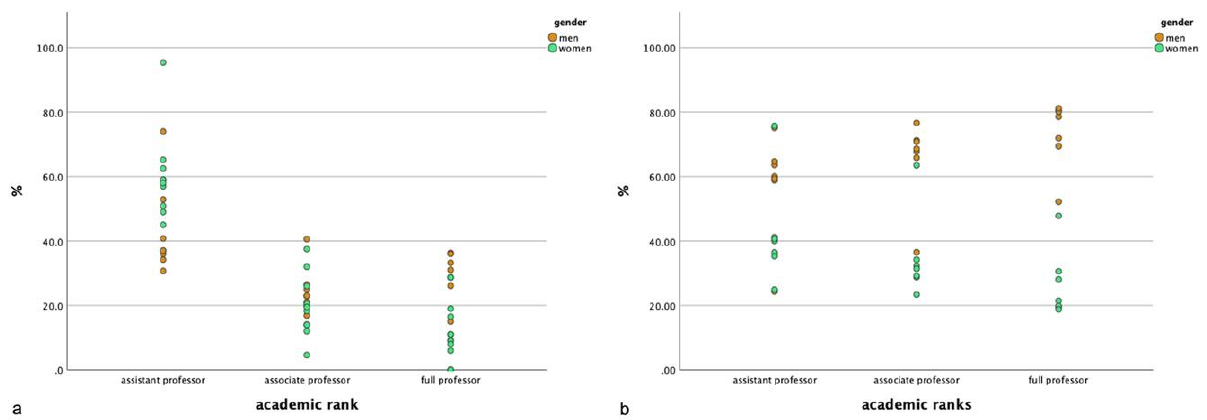
Figure 3. Distribution of academic ranks based on within-gender analyses ( a ) and analyses at the academic level ( b ).